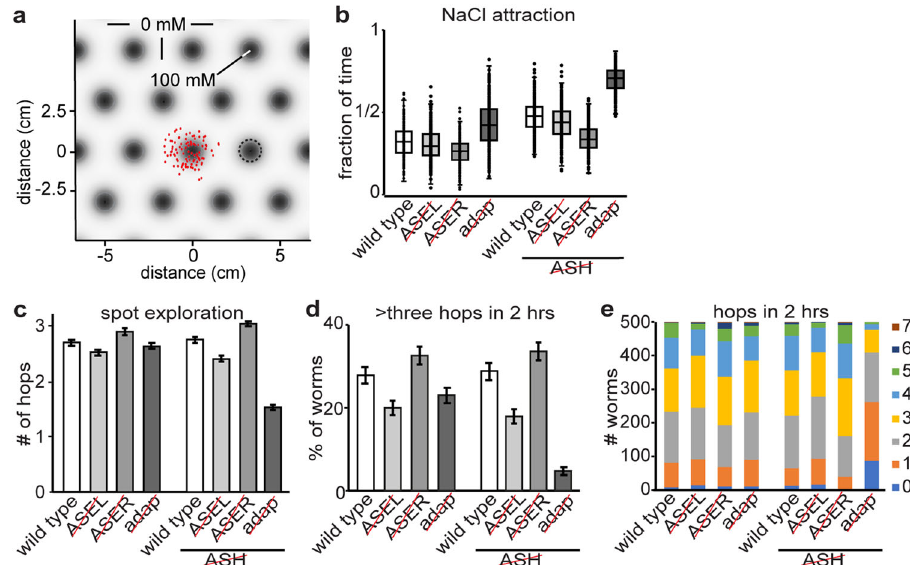
Fig. 9 Sensory adaptation controls exploration in a virtual spot assay. a Spot assay arena with identical salt spots with Gaussian salt concentration peaking at 100 mM. Peaks are positioned on an in fi nite hexagonal grid. The standard deviation for each spot is 0.6 cm and the distance between the two nearest spots is 3 : _ 3 cm. Populations of 500 worms each were simulated for 1 h. Naïve worms were initialized in the center of a single spot, with random orientations. b Salt attraction in the spot assay for eight different populations, measured as the fraction of time a worm dwells on salt (>25 mM). c – e Exploration is quanti fi ed as the number of times a worm changes from one spot to another for eight different populations. For each population, 500 worm trajectories were analyzed. c The average number of hops achieved within 2h (±SEM). d The percentage of worms that made four or more hops within 2 h (±SEM). Note the sixfold difference between the simulations with ( “ wild type ” , 28.8%) and without ( “